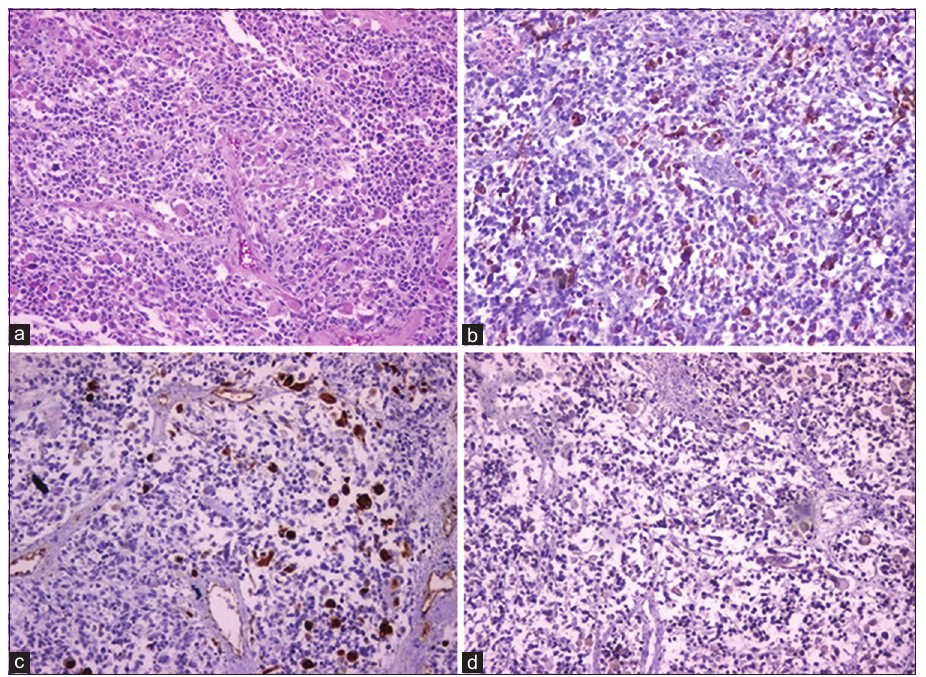
Figure 1. Histopathologic features of paratesticular alveolar subtype rhabdomyosarcoma (a) Tumour cells are seen with hyperchro- matic nucleus and spindle eosinophilic cytoplasm. Alveolar subtype of rhabdomyosarcoma were presented with desquamated small, round, and poorly differentiated cells (HE.x10), (b) Tumour cells were positive with actin (x10), (c) Tumour cells were positive with desmin (x10), (d) Tumour cells were positive with myoglobulin